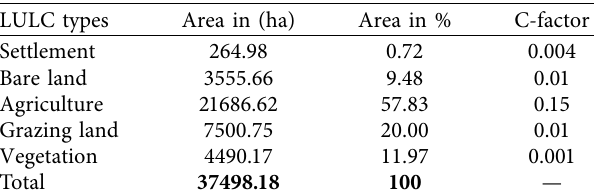
Figure 5: Slope length and steepness map (LS-factor map). Table 3: Cover (C) factor of the